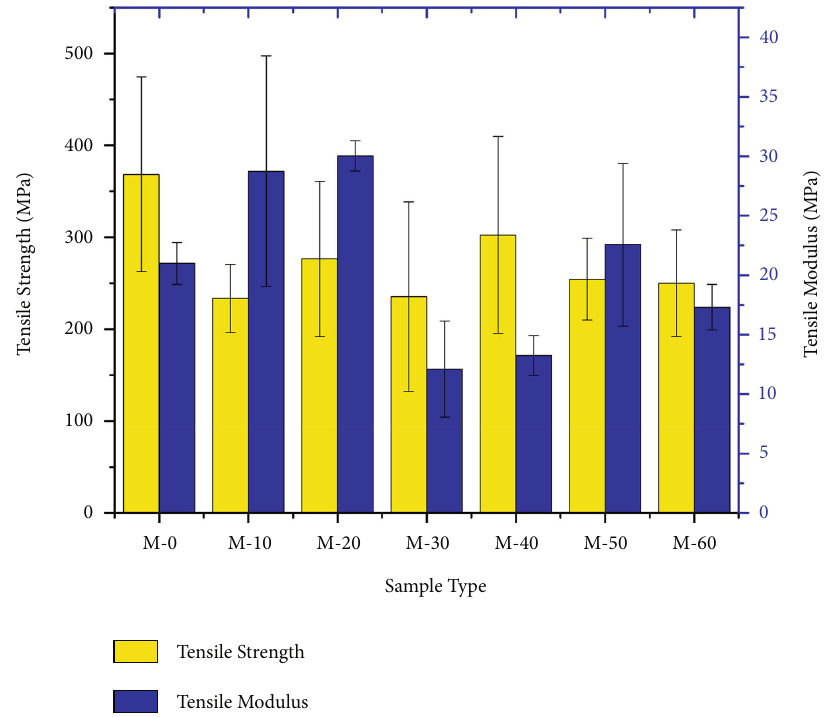
Figure 11: Tensile strength and tensile modulus for mango seed shell/epoxy